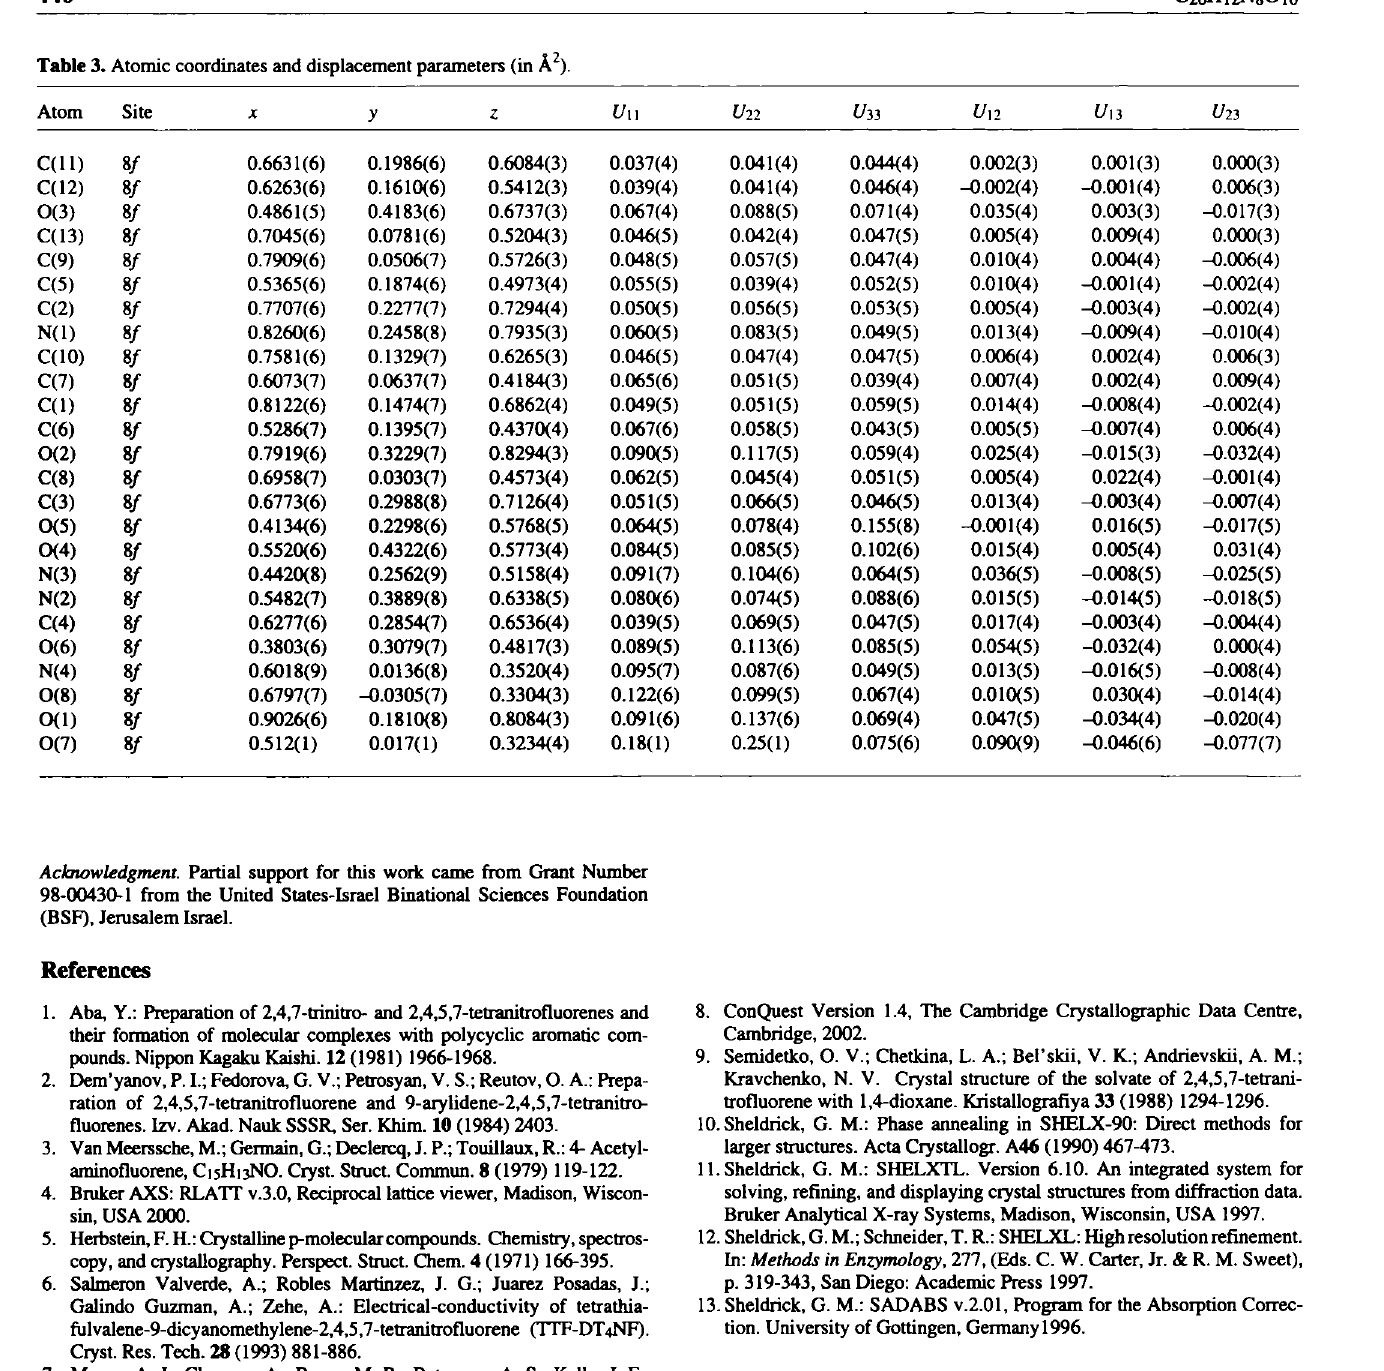
Table 3. Atomic coordinates and displacement parameters (in Â 2